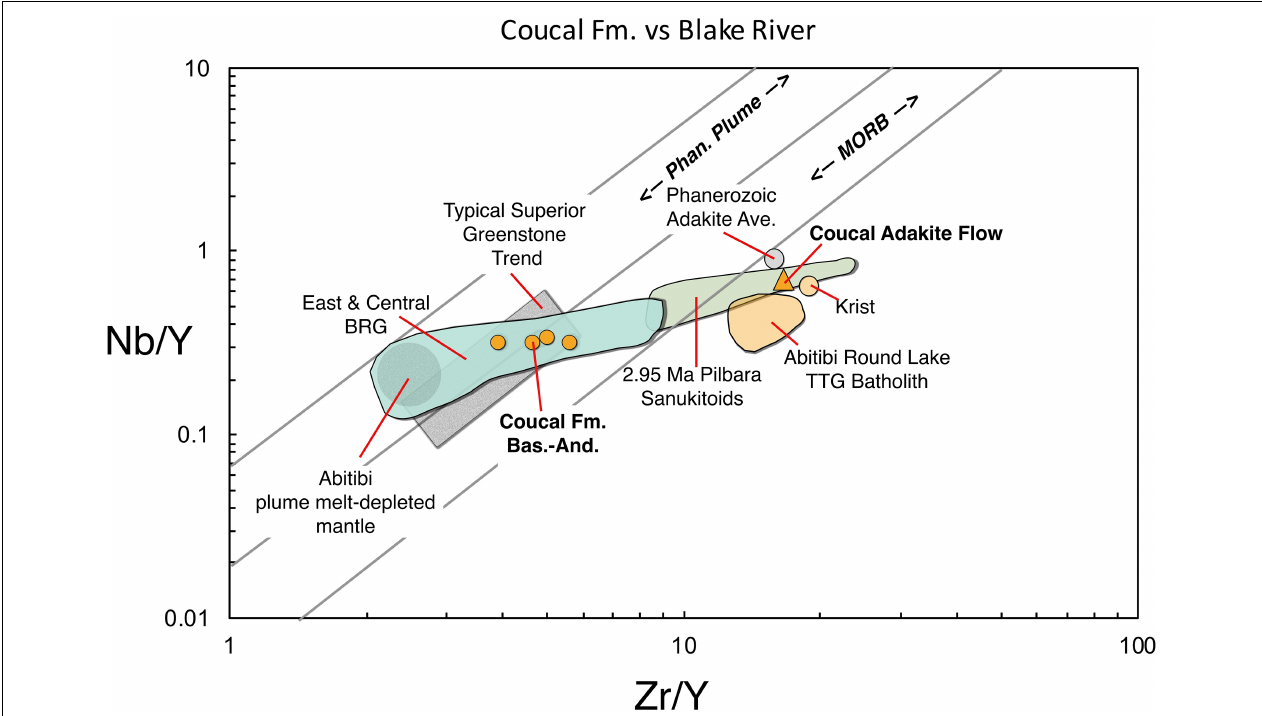
FIGURE 6 | A plot of Nb/Y vs. Zr/Y showing a comparison of the ∼ 3500 Ma Coucal Formation basalts, andesites and adakite with Abitibi belt volcanic rocks from the Blake River Group (BRG), including the adakitic Krist Fragmental unit. Also shown is the adakitic phase of the Abitibi belt Round Lake batholith and 2950 Ma sanukitoid high-Mg diorites from the west Pilbara. The low Zr/Y part of the BRG trend is inferred to correspond to melts derived from mantle plume-depleted sources. Most Superior Province mafic volcanic suites plot parallel to the main arrays, even when derived from areas of mature crust, such as the Uchi Subprovince margin. Wyman and Hollings (2006) interpreted the BRG trend as a product of adakitic metasomatism of mantle sources, as did Smithies and Champion (2000) for the similar High-Mg diorites. The plot and reference arrays are adapted from Fitton et al. (1997) and Wyman and Hollings